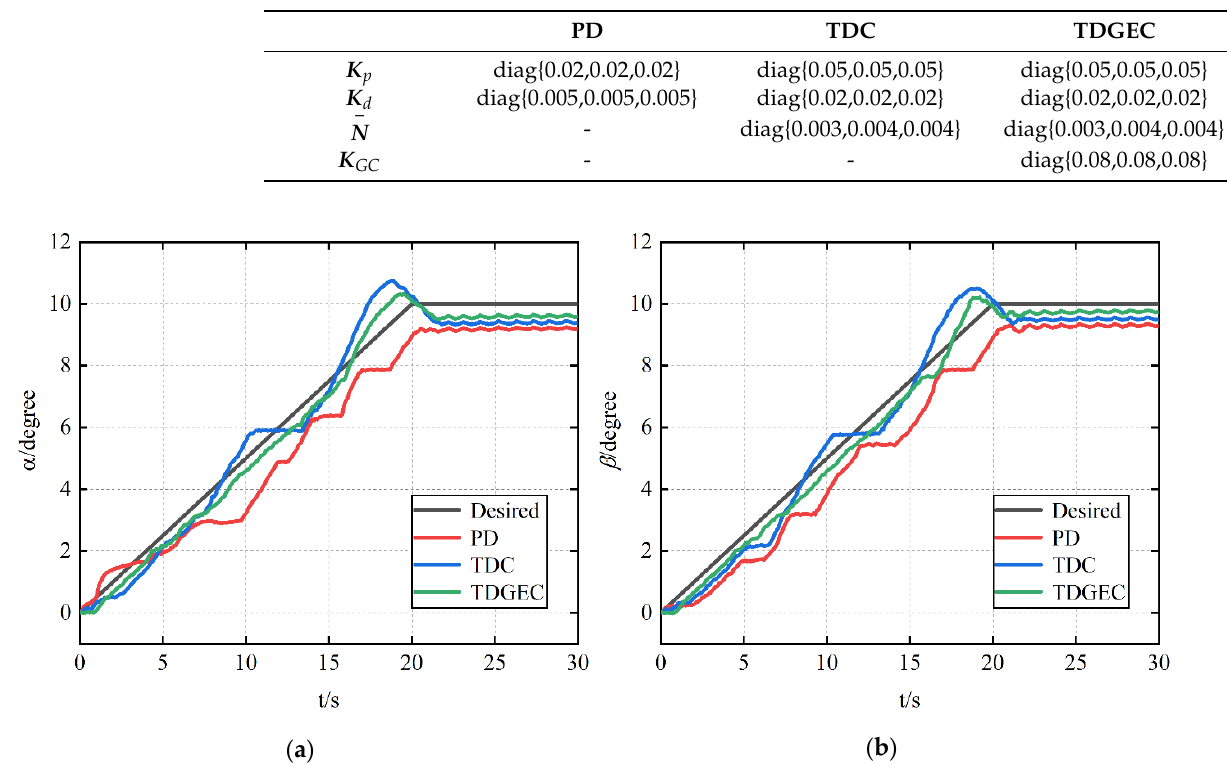
Table 5. The SSE, AME, and the standard deviation.